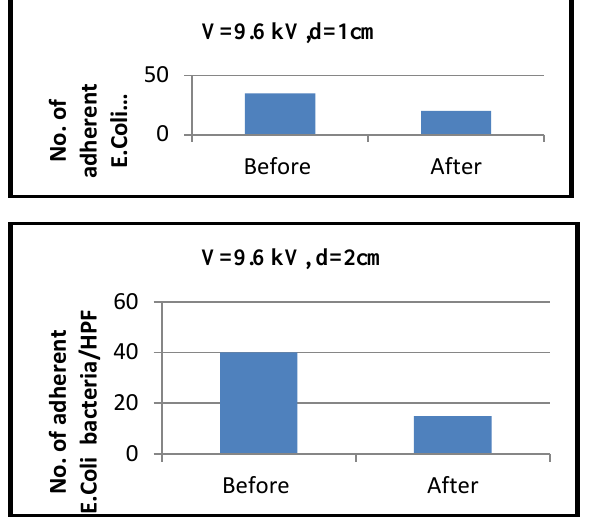
Figure (6): Mean values of No. of adherent E.Coli bacteria to epithelial cells before & after treatment with plasma needle . Figure (7) shows the mean values of No. of bacteria attached to epithelial cells before & after treatment with plasma, where it decreases after treatment at applied voltage 10.6 kV, distances between plasma needle and substance(treatment model) were 2 and 1 cm and frequency 33 kHz through period 1.30 min..